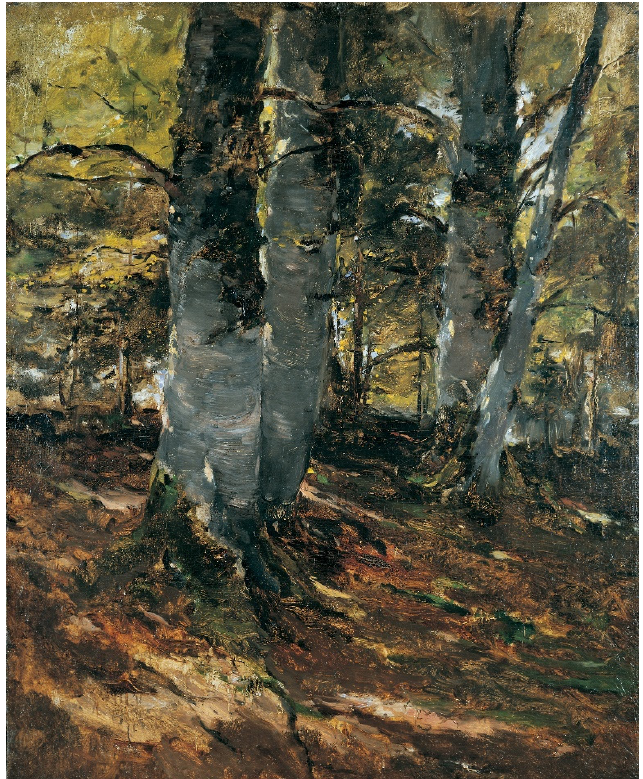
Figure 10. Frank Duveneck, Beechwoods at Polling, Bavaria , ca. 1878, oil on canvas, 115.6 × 94 cm. © Cincinnati Art Museum / Gift of the Artist / Bridgeman Images.